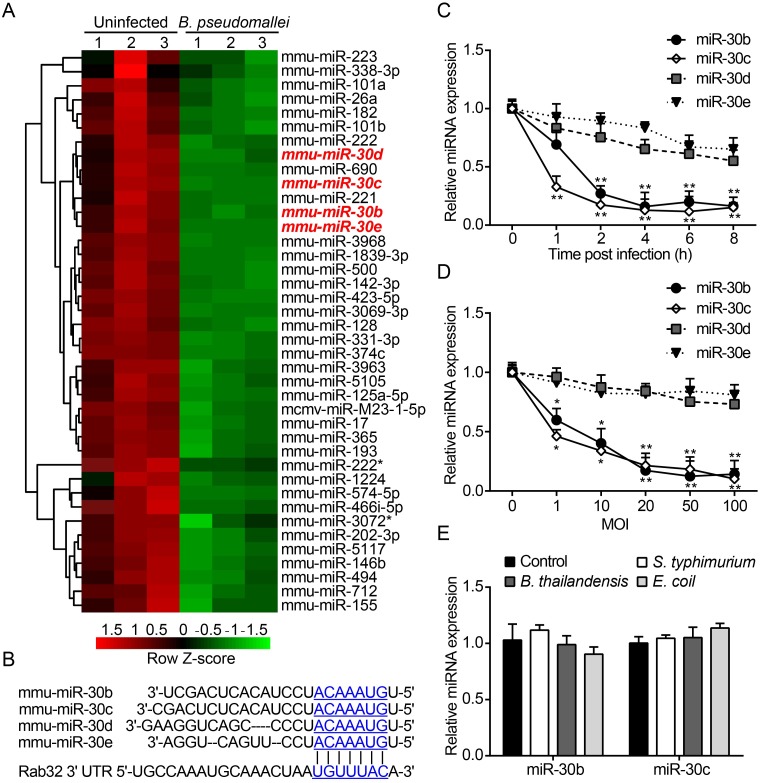
MiR-30b and miR-30c are downregulated after B. pseudomallei infection.(A) Total RNA from RAW264.7 cells were infected with B. pseudomallei for 4 h to perform microarray assay. Hierarchical clustering analysis was performed to show downregulated miRNAs by B. pseudomallei infection. (B) The region of the mouse Rab32 mRNA 3′UTR predicted to be targeted by miR-30b, miR-30c, miR-30d, and miR-30e, respectively (TargetScan 6.2). (C and D) Confirmation of microarray results by qRT-PCR. qRT-PCR analysis of the expression levels of miR-30b, miR-30c, miR-30d, and miR-30e in RAW264.7 cells infected with B. pseudomallei (MOI = 10) for 0, 1, 2, 4, 6, and 8 h, or at MOI = 0, 1, 10, 20, 50, and 100 for 4 h. (E) Expression of miR-30b and miR-30c in RAW264.7 cells infected with B. thailandensis, S. typhimurium and E. coli (MOI = 10). *P<0.05, **P<0.01. Experiments performed in triplicates showed consistent results.